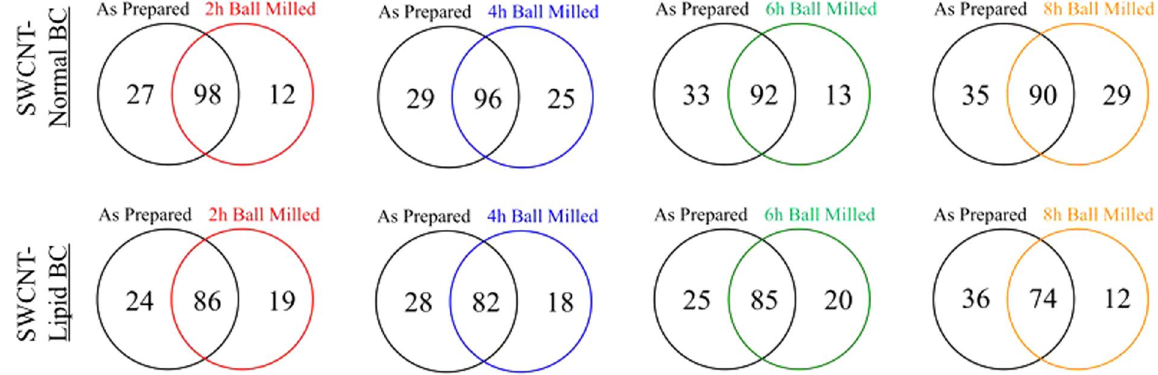
Figure 2. Venn diagrams representing the number of proteins found to associate with SWCNTs following incubation in either 10% normal or 10% hyperlipidemic serum comparing As Prepared SWCNTs to SWCNTs that have undergone ball milling (n =